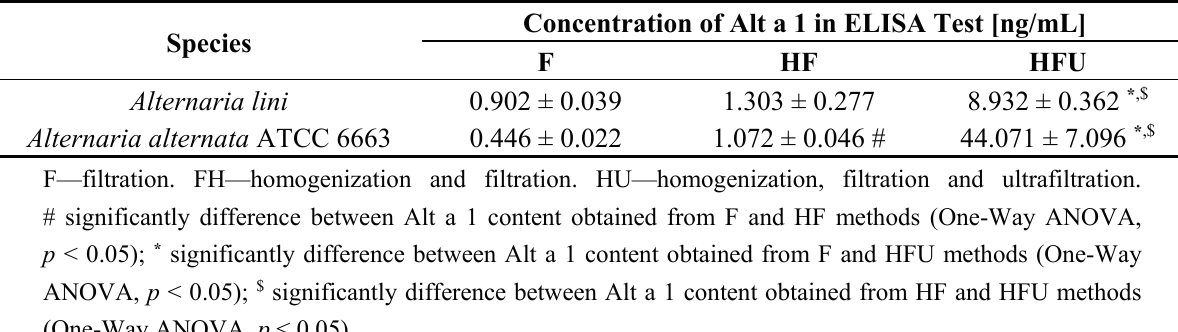
Table 6. Comparison of methods of Alt a 1 protein obtaining for selected strains of Alternaria